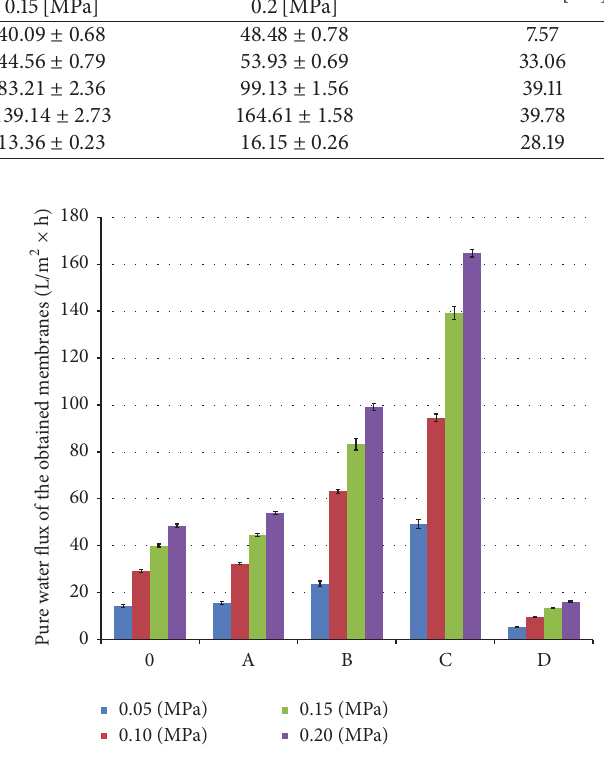
Figure 5: Transport properties of